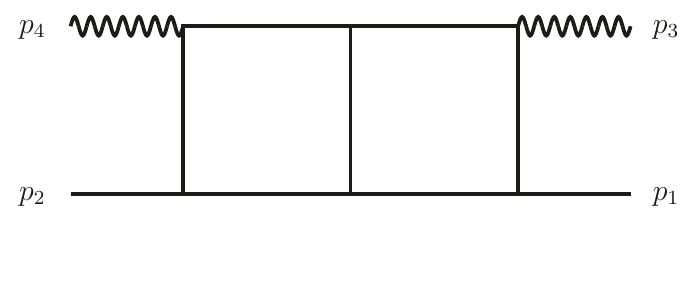
Figure 4 . Two loop graph of topology